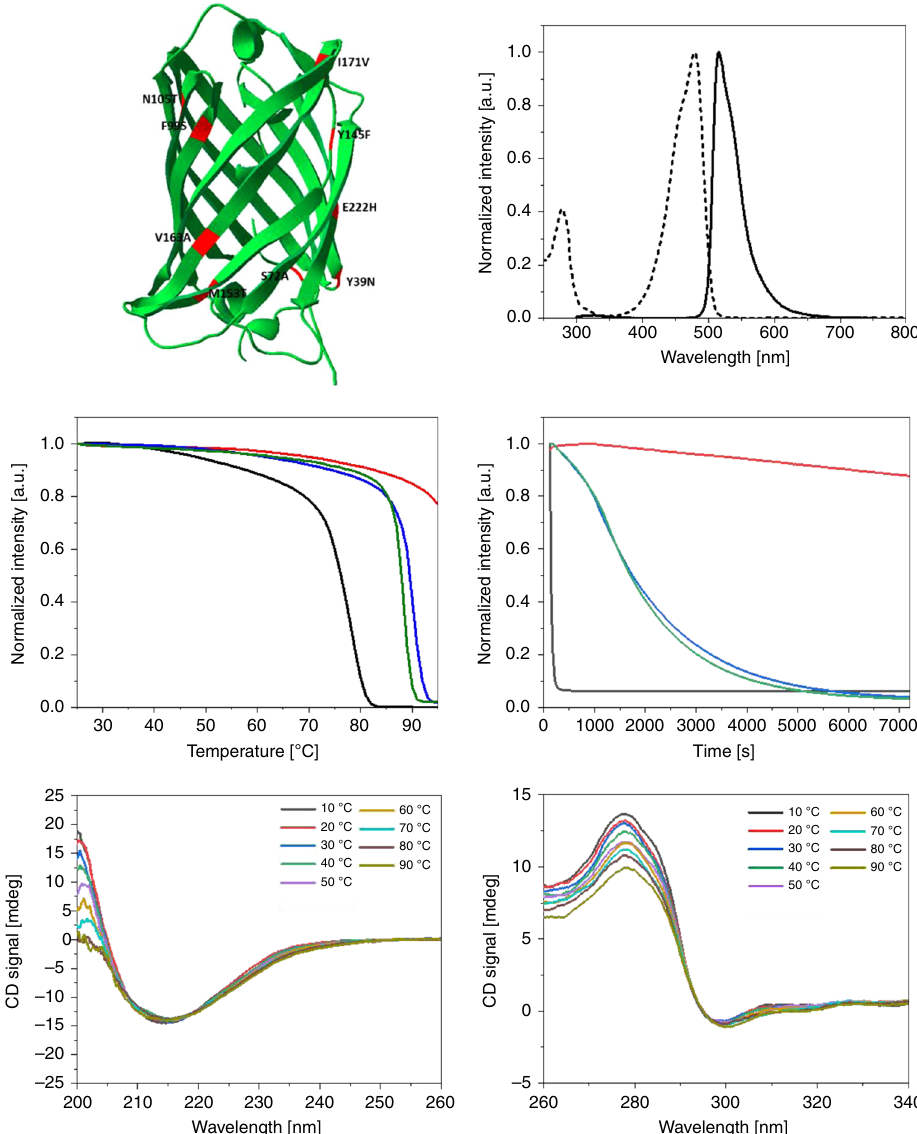
Fig. 1 Characterization of GFP variants. Top: three-dimensional (3D) structure of the mutant eGFP-AA (left) (the 3D-model was made with Swiss PDB Viewer version 4.1 using the PDB fi le 2WUR as template) with the mutations E222H, Y39N, S72A, F99S, N105T, Y145F, M153T, V163A, and I171V highlighted in red, as well as absorption (dashed line) and emission (solid line) spectra of eGFP-AA in solution (right). Center: Photoluminescence ( λ exc = 488 nm) stability upon heating (left) and at 85 °C (right) of eGFP (black), eGFP-AA (red), eGFP-E222H (blue), and eGFP-FF (green). Bottom: CD spectra of eGFP-AA at different temperatures (see legend), showing the secondary structure (left) and the near-UV spectra reporting on the tertiary structure